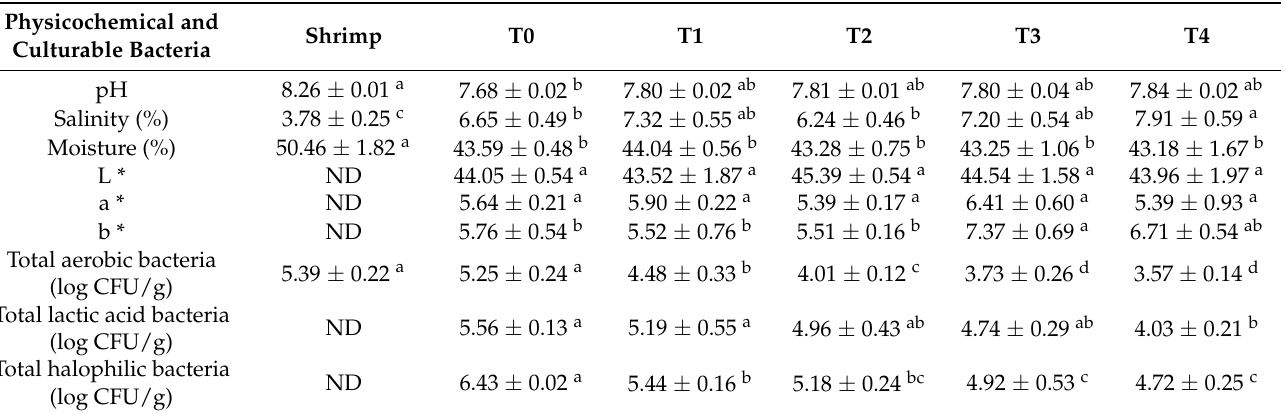
Table 2. Physicochemical and cultural bacteria changes in shrimp material and low-salt shrimp paste during